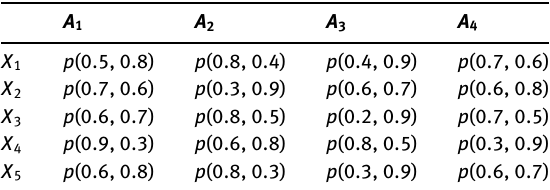
Table 1: Pythagorean Fuzzy Decision Matrix R (1) .